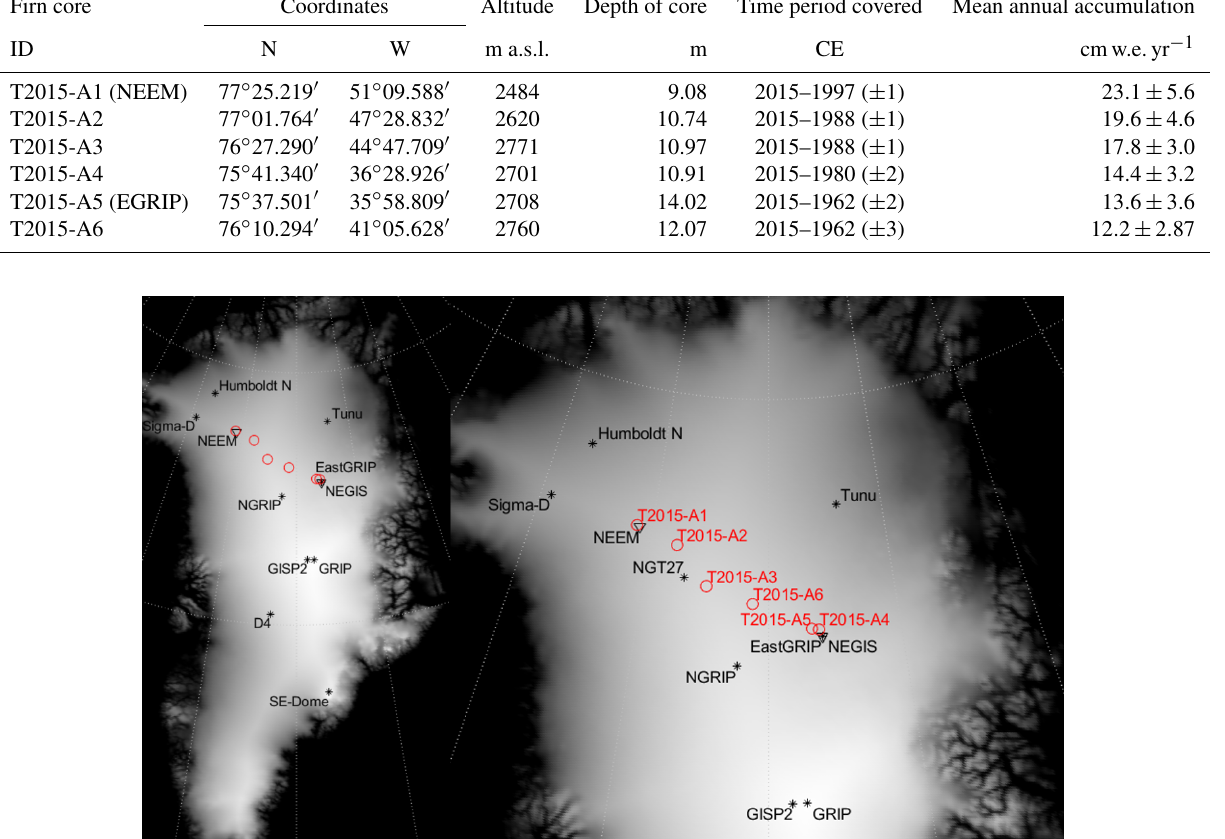
seasonality was not well resolved, i.e., T2015-A4,